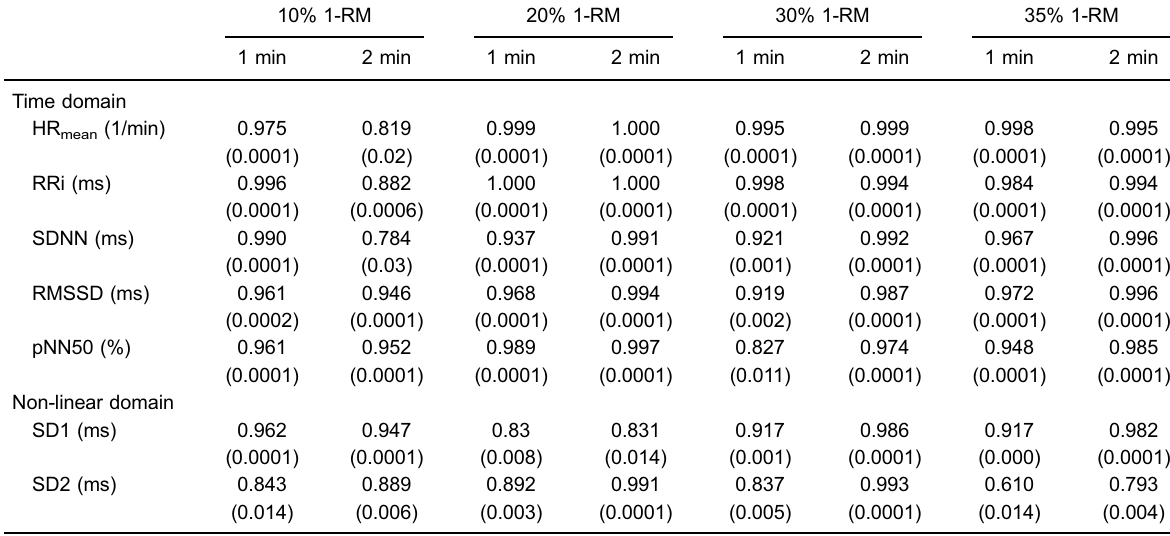
Table 3. Intraclass correlation coef fi cient (ICC) between linear and non-linear parameters calculated at different exercise intensities over 1 and 2 min signals and parameters calculated over 3 min